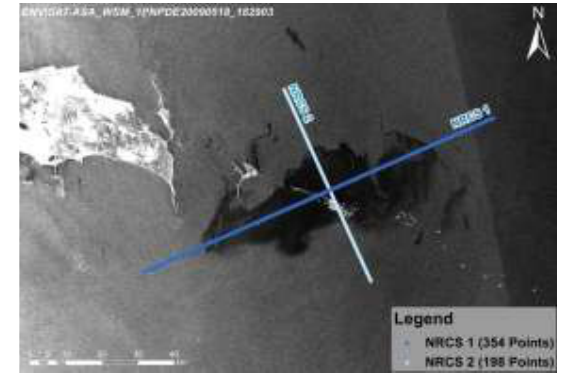
Figure 11. Map of normalized radar cross sections based on the ENVISAT radar images acquired on 18 May 2009 at 18:29.